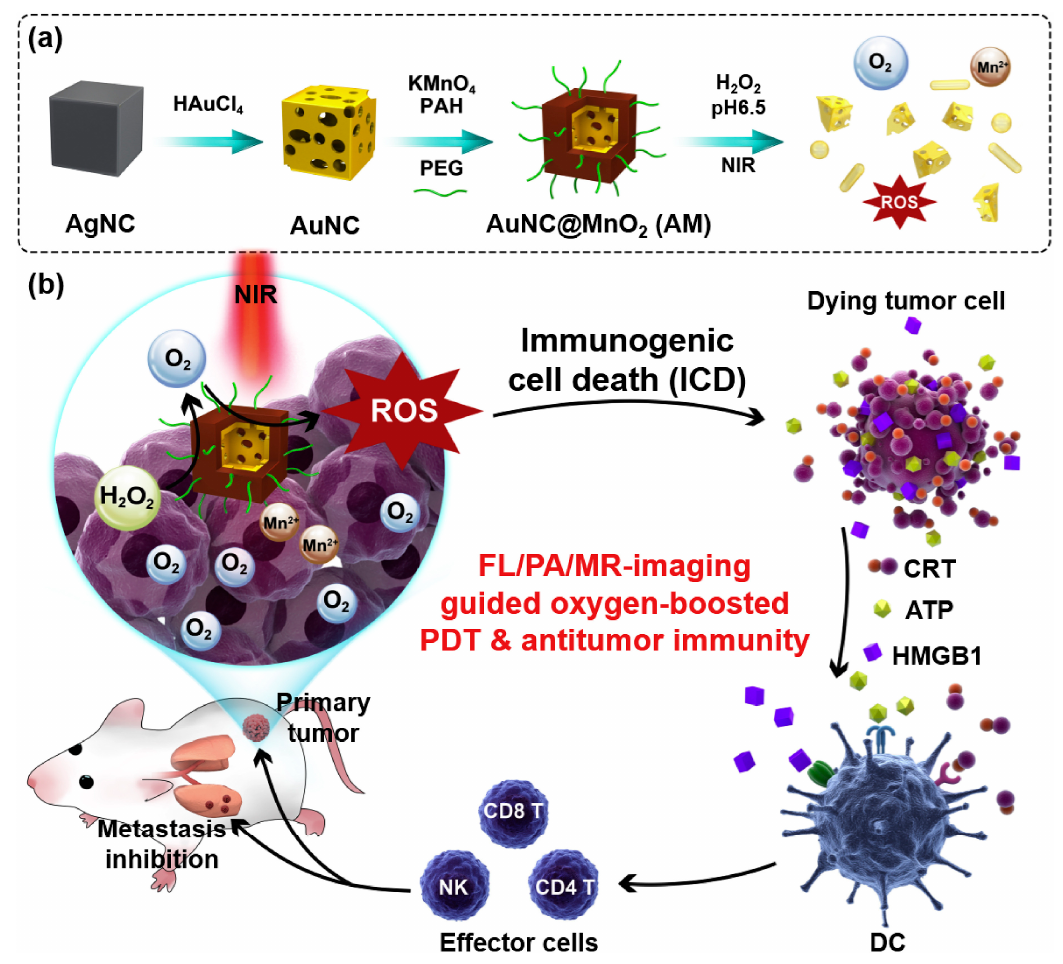
Figure 1. Schematic representation of ( a ) synthesis of AuNC@MnO 2 (AM) and ( b ) imaging-guided PDT ef-ficiency of AuNC@MnO 2 (AM) reproduced with permission [125]. Copyright 2018